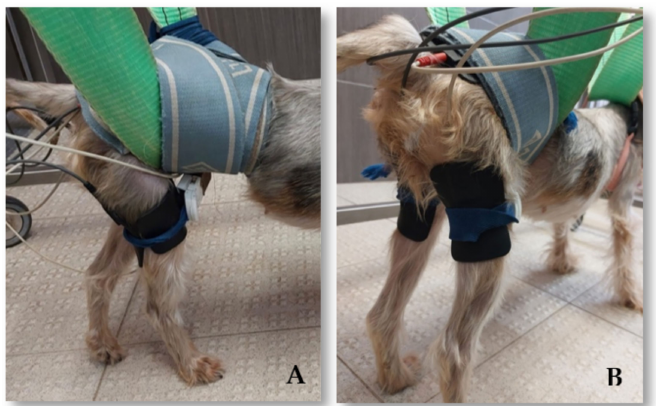
Figure 2. Electrical stimulation protocols on a dog in a postural standing position. ( A ) Co-contraction protocol with the stimulation of both the quadriceps femoris group and the hamstring muscles group.